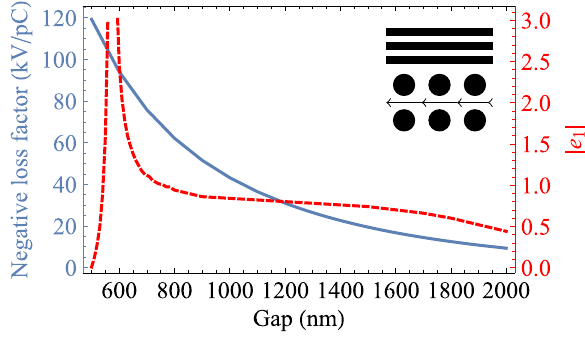
FIG. 4. Loss factor indicating the strength of wake effects as function of the vacuum gap compared to the absolute value of the first Fourier coefficient indicating the accelerating gradient in the center of a fused silica dual pillar structure with 2 μ m period length for a given external field